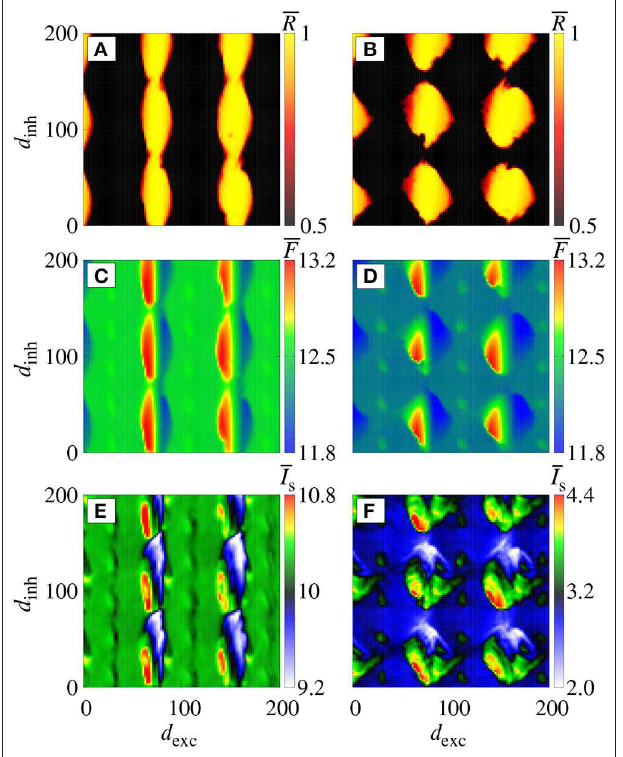
FIGURE 3 | Magnifications of the parameter spaces shown in the right column of Figure 2 . (A) R , (B) F , and (C) I s for g exc = 0.2 nS and g = 6 on the parameter space d exc × d inh